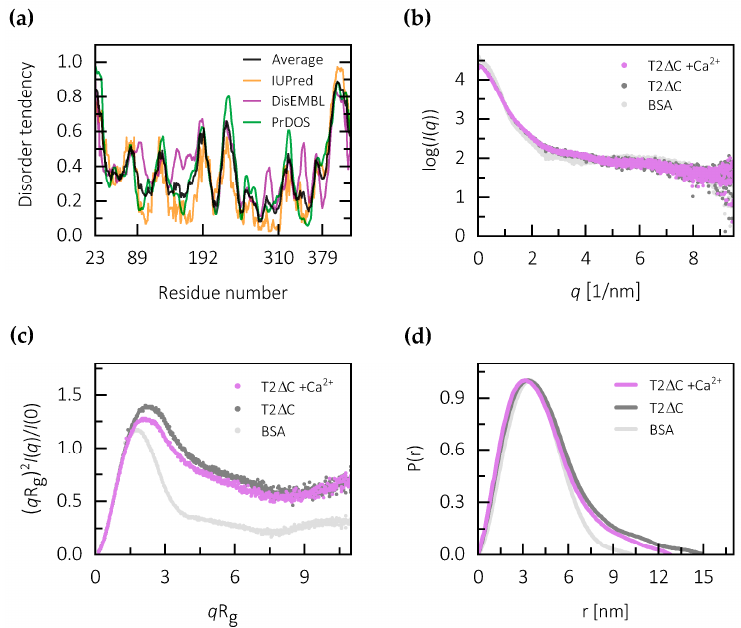
Figure 3. Disorder analysis of testican-2. ( a ) Disorder tendency plot for testican-2. The average value from all three tools used is represented in black. Marked residue numbers correspond to approximate borders between N-region, FS, EC and TY domains, and the C-region. ( b ) Scattering profile I ( q ) vs. q as log-linear plots for calcium-free (T2 Δ C), calcium-loaded testican (T2 Δ C + Ca 2+ ) and BSA (used as a standard). ( c ) Dimensionless Kratky plots showing bell-shaped peaks with elevated plateau values at high q , indicating that the conformation of T2 Δ C is not as compact as of BSA, for which a defined Gaussian-like peak was observed. ( d ) Normalized bell-shaped P(r) versus r profiles with D max of 13.8 nm for a calcium-loaded sample and 14.5 nm for a calcium-free sample. The tail-like extension of the curve at higher r values for testican as compared to BSA indicates flexibility.